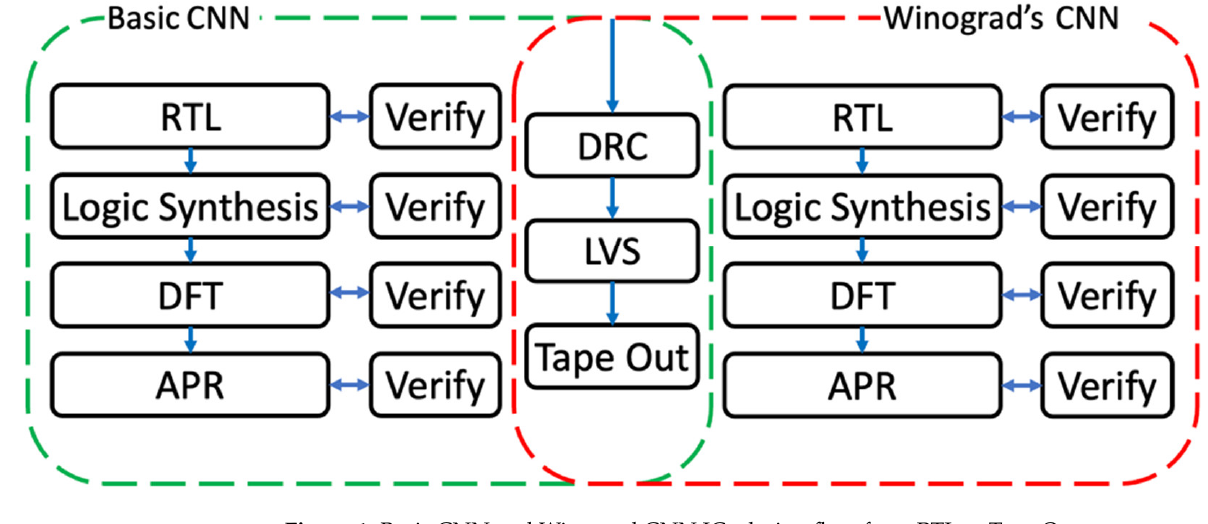
Figure 1. Basic CNN and Winograd CNN ICs design flow from RTL to Tape Out.